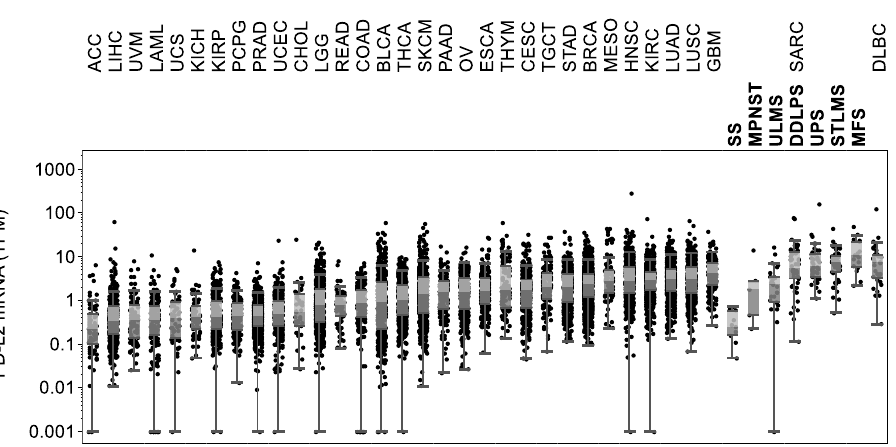
Figure 4. Key immune-related and checkpoint genes are expressed in all soft tissue sarcoma subtypes.